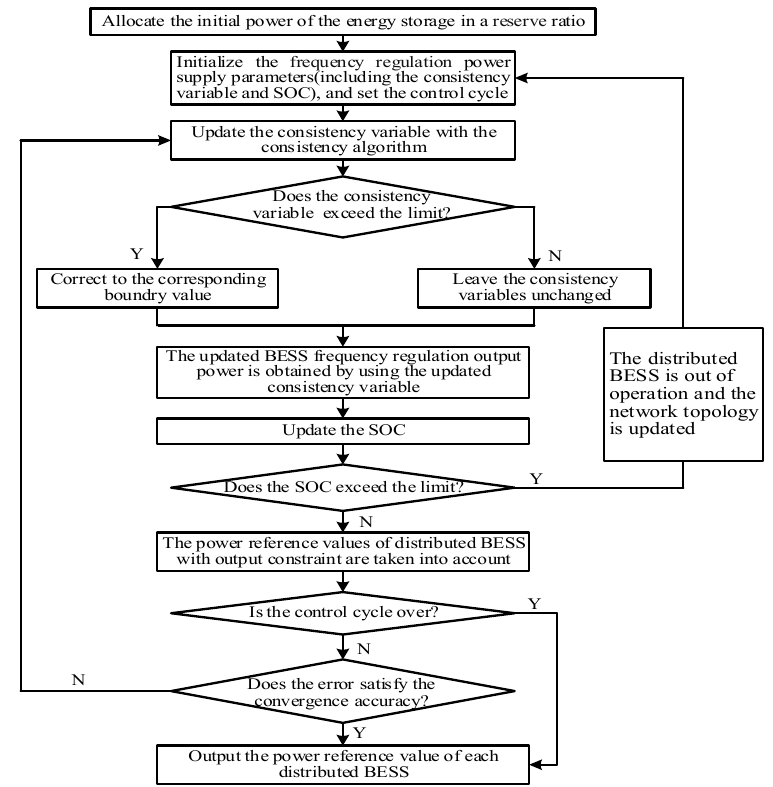
Figure 7. Coordination control flowchart during the control cycle.